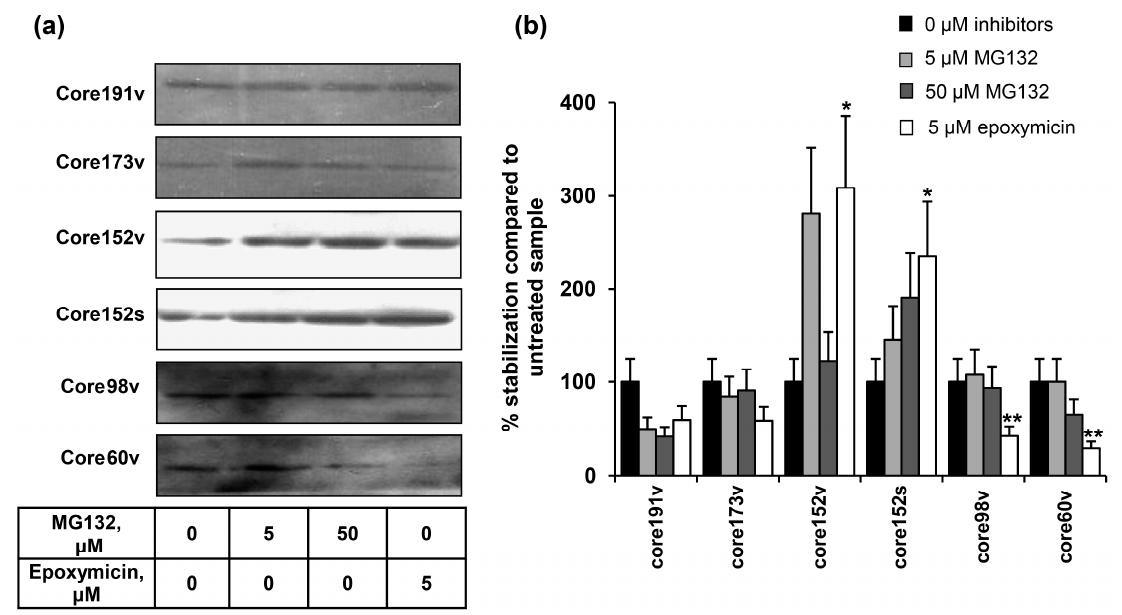
Figure 3. The effect of proteosome inhibitors on the accumulation of HCV core protein variants. ( a ) Western blotting with anti-core rabbit antibodies after transfection of BHK-21 cells and 24 h incubation (lane 1), and additional 24 h incubation with proteosome inhibitors with subsequent lysis (lanes 2–4); ( b ) Quantification of images using ImageJ software; signals from the cell cultures treated with proteasome inhibitors were normalized to the signal generated by respective HCV core variant in untreated cells; Y axis shows % stabilization. Data represent the results of two independent experiments. * Core1-152 was better stabilized by epoxomycin treatment than other HCV core forms ( p < 0.05); ** core1-98 and core1-60 were not stabilized by epoxomycin treatment as compared to all other HCV core forms ( p < 0.05; Tukey–Kramer test).